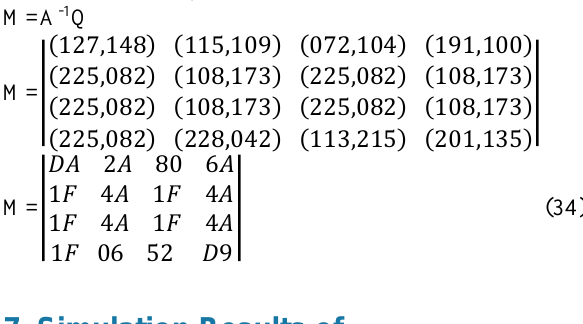
Figure 9 . Expanded Block Diagram of